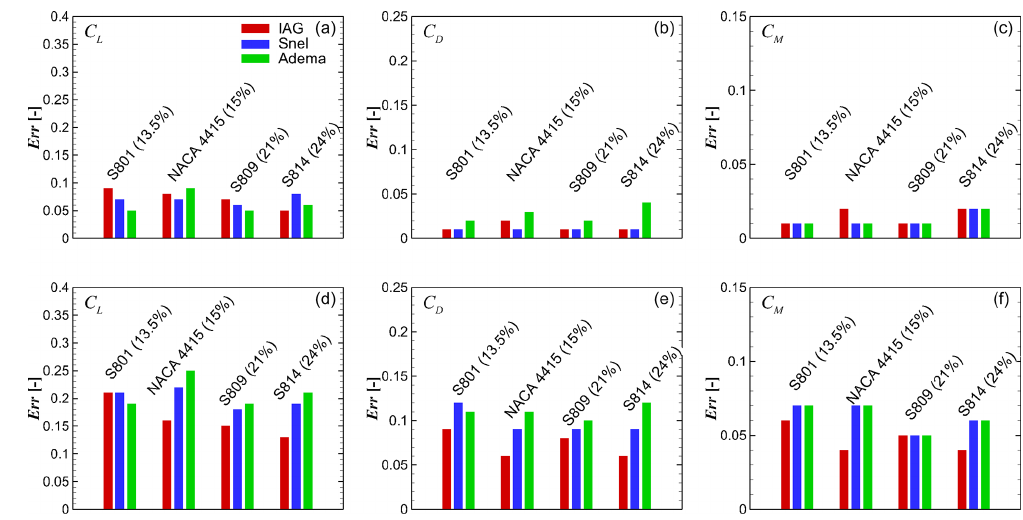
Figure 27. Quantified L 2 norm of error with respect to the measurement data for four airfoils. (a–c) Attached flow case ( k = 0 . 073, α = 8 ◦ , (cid:49)α = 5 . 5 ◦ ); (d–f) deep-stall case ( k = 0 . 073, α = 20 ◦ , (cid:49)α = 10 ◦